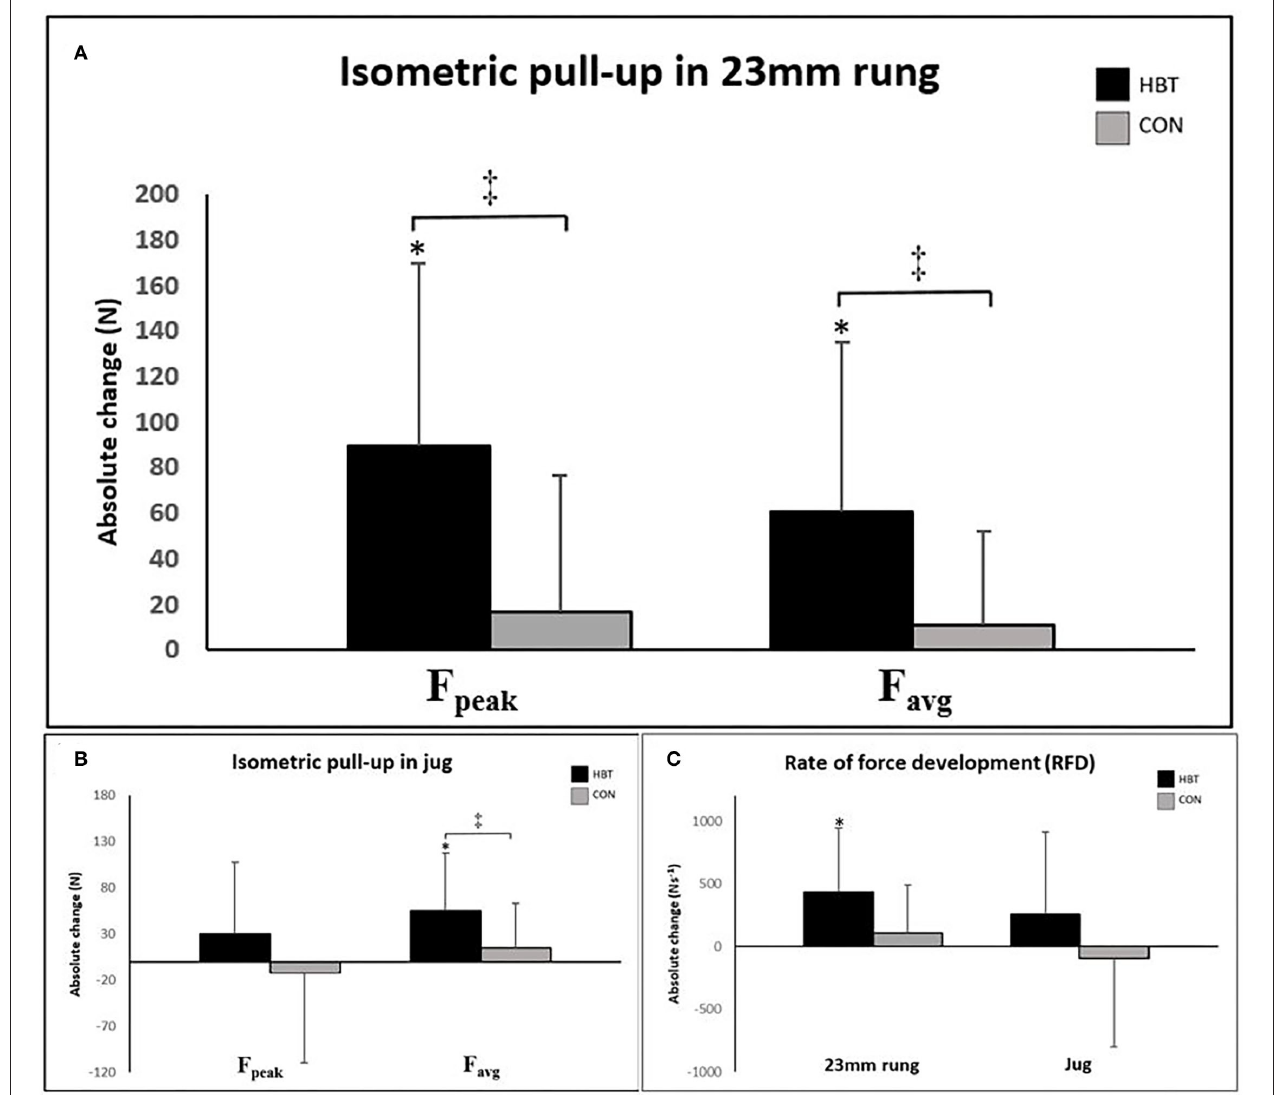
FIGURE 2 | Absolute change in isometric pull-up (A) F peak and F avg on the 23 mm campus rung, (B) F peak and F avg on the jug, and (C) the rate of force development (RFD) in the 23mm rung and jug conditions. Error bars represent standard deviations (SDs). *Significant change from pre-test ( p < 0.05). ‡ Significant difference in change between groups ( p <